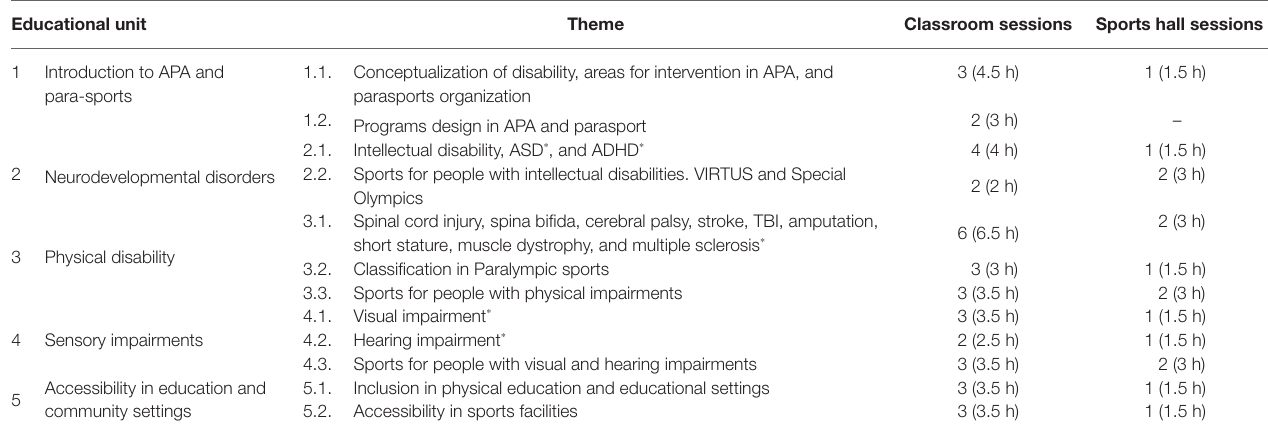
TABLE 2 | Structure of the course